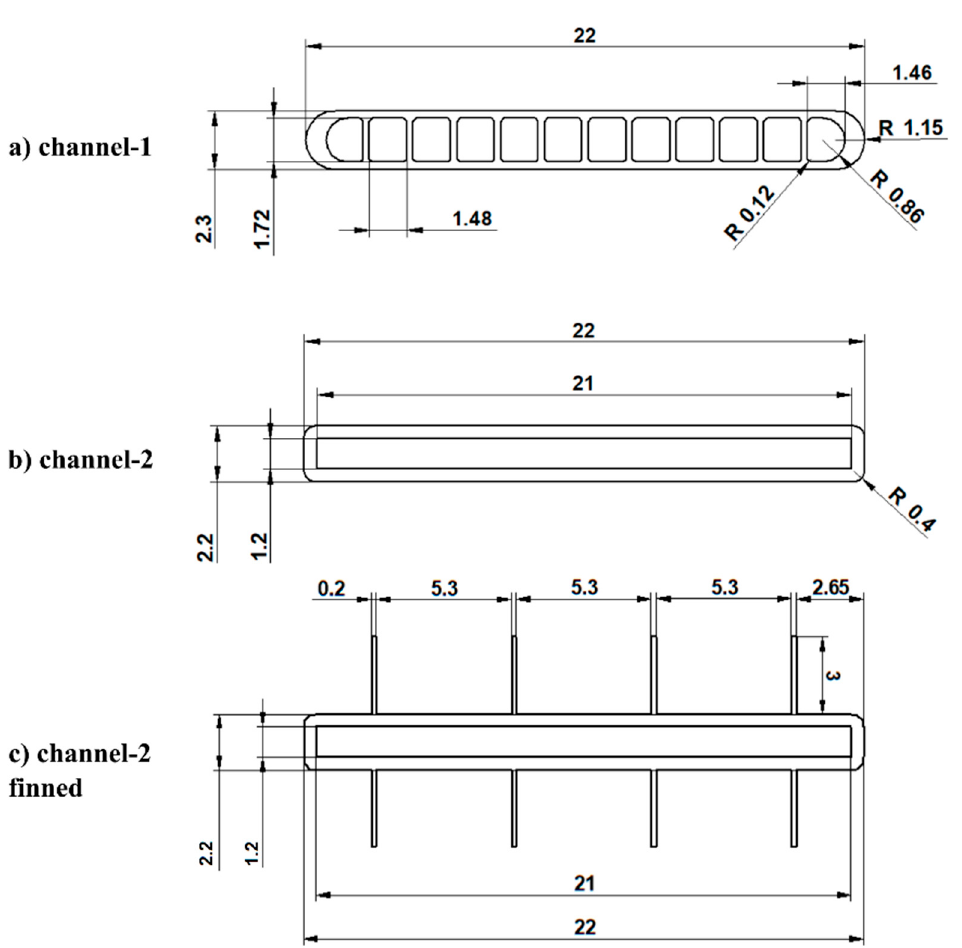
Figure 2. Dimensions of the simulated configurations: ( a ) channel-1, ( b ) channel-2 and ( c ) channel-2 finned. Table 1. Geometrical characteristics and material properties of the channels.